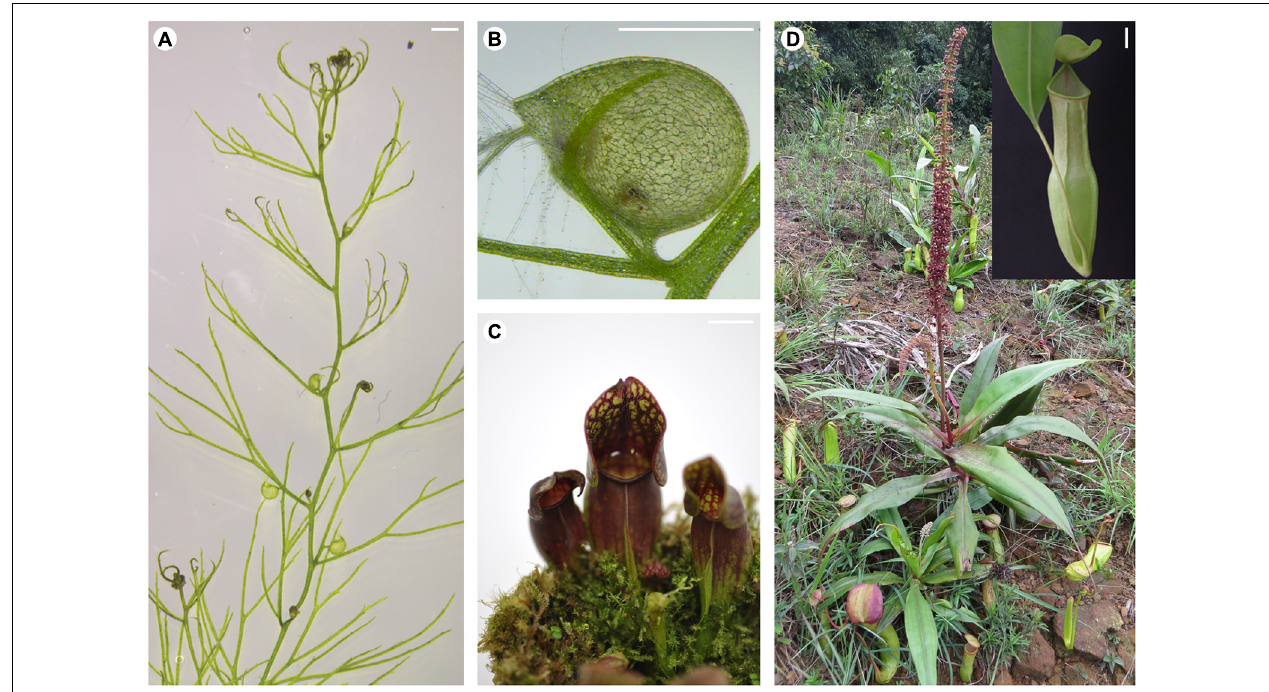
FIGURE 1 | Innovative leaf morphologies of selected carnivorous plants. (A) Stolon of a U. gibba plant showing leaves with or without traps. (B) Close-up view of a U. gibba trap. (C) Pitcher-shaped leaves of S. purpurea . (D) A N. khasiana plant in the wild bearing pitcher-shaped leaves (inset shows close-up view of the N. khasiana pitcher). (A,B) Bar = 1 mm; (C,D) bar = 10 mm.